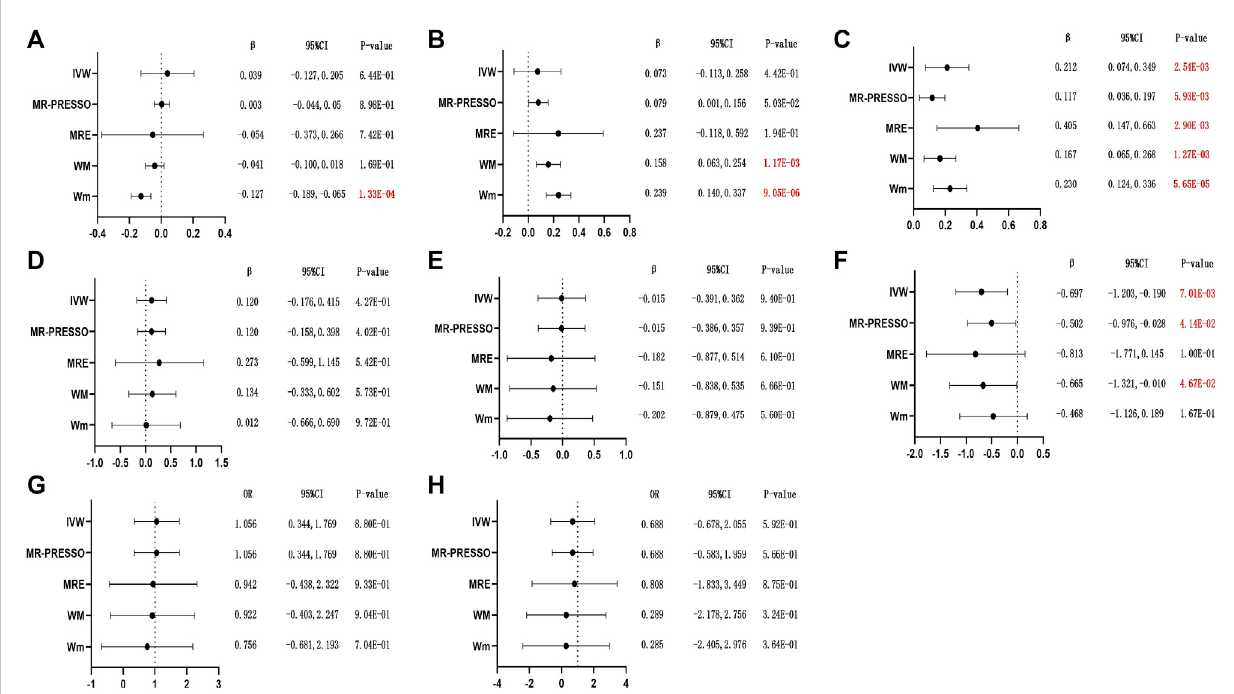
FIGURE 2 MRresultsofcausaleffectsofalcoholdrinkingSNPsonrelatedoutcomerisks.(Theestimateswerederivedfromtherandom-effectsIVWmodel,the MR-PRESSO approach, MRE regression, WM, and Wm. (A – H) : (A) SHBG; (B) bio-T; (C) TT; (D) E 2 ; (E) AMH; (F) age at menopause; (G) irregular menstrual cycle/bleeding;and (H) dysmenorrhea.OutliersofMR-PRESSO: (A) rs705687,rs56337305,rs13094887,rs11940694,rs6460047,rs35034355,rs1217091, rs55932213, rs7074871, rs62044525, rs7185555, and rs2532276; (B) rs705687, rs56337305, rs13094887, rs4501255, rs35034355, rs1217091, rs28601761, rs55932213, rs11625650, and rs62044525; (C) rs705687, rs13094887, rs4501255, rs35034355, rs28601761, and rs11625650; (D) N; (E) N;